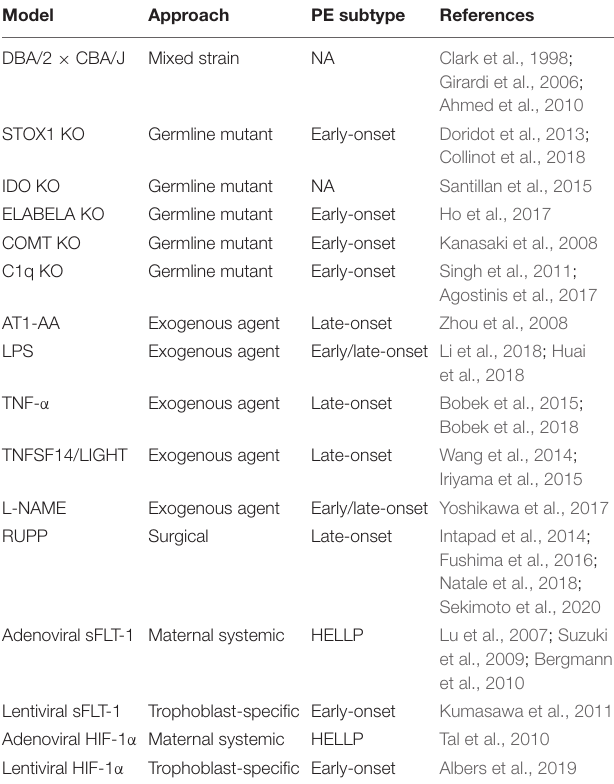
TABLE 1 | Mouse models of preeclampsia.